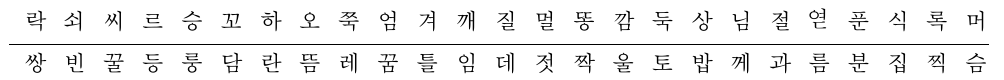
Figure 7. Comparison of intelligibility score and STI using three types of speech intelligibility test methods.